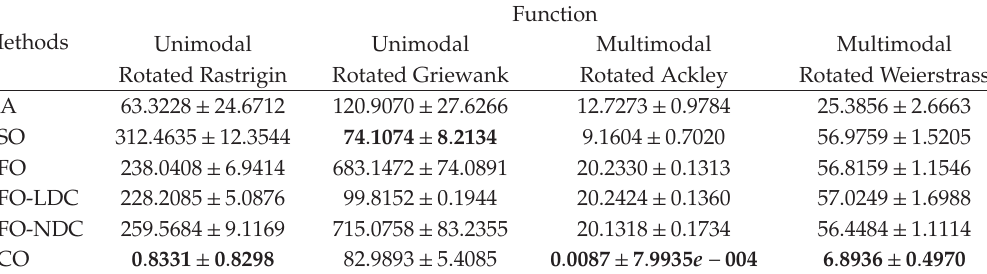
Table 7: Experimental results on rotated benchmark functions f 9 ∼ f 12 (cid:3) 40-D (cid:4) .